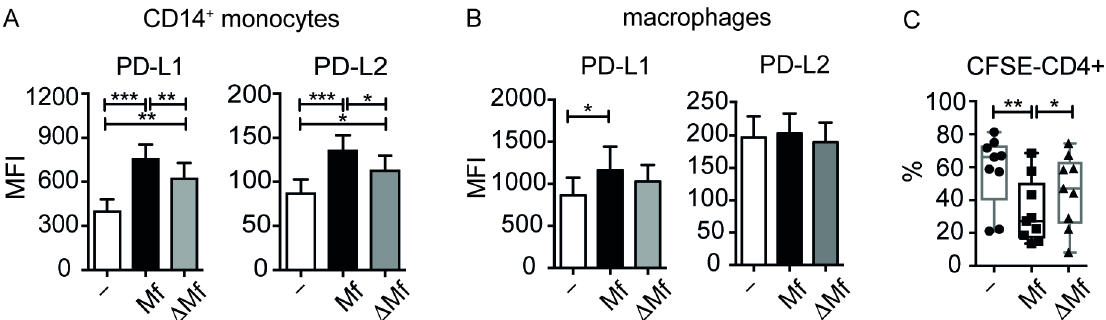
Fig 4. Mf-induced PD-L1 and PD-L2 on monocytes is dependent on the presenceof filarial cystatins. A) Human monocytes, and B) monocyte-derivedmacrophages were stimulatedwith 20 μ g/ml of Mf or Δ Mf for 24 h. Surface expressionof PD-L1 and PD-L2 was measuredby flow cytometry. Bar graphs show the mean fluorescence intensity (MFI). Data are from 16 (monocytes) and 9 (macrophages) donors, respectively, and shown as mean ± SEM. C) Flow cytometric analysisof CD4 + T cells. 5x10 5 CFSE-labelledCD4 + T cells were co-cultured for 5 days with 1x10 5 monocytes left either unstimulated or stimulatedfor 24 h with 20 μ g/ml Mf or 20 μ g/ml Δ Mf. Graph shows the percentage of CD4+ T cells that divided. Data are from 9 donorsand shown as mean ± SEM. Statistical analysiswas doneusing the Wilcoxon matched-pairs signedrank test. * p < 0.05, ** p < 0.01, *** p < 0.001.